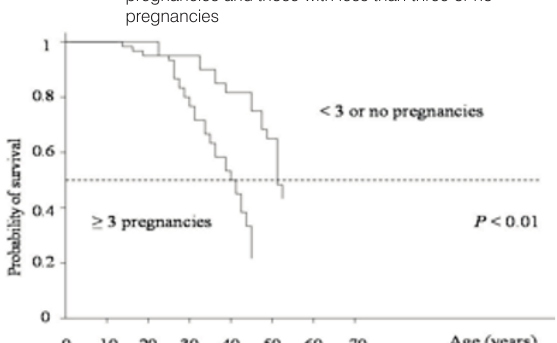
Figure 3. Renal survival in female patients with three or more pregnancies and those with less than three or no